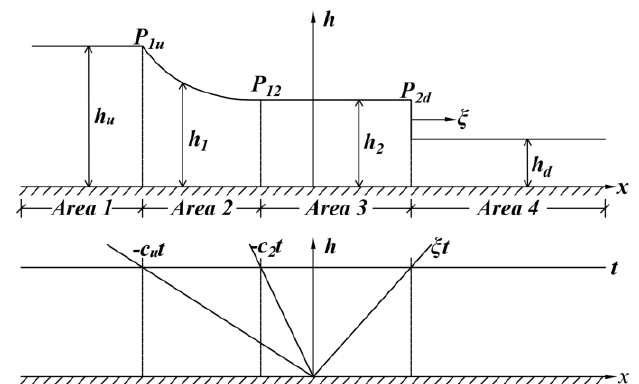
Figure 5. Dam break flood evolution model.